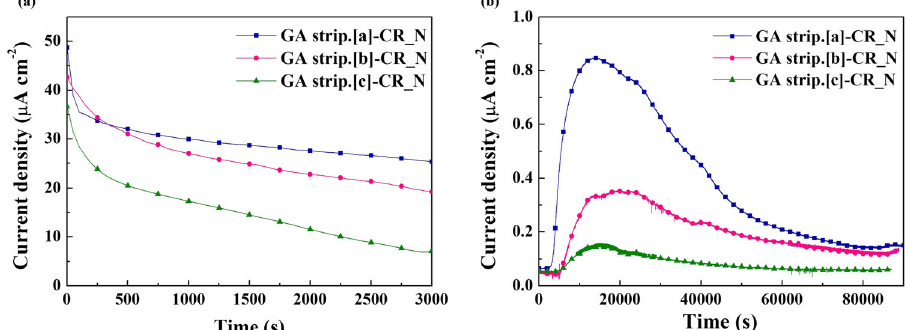
Fig. 13 Galvanic corrosion and hydrogen permeation behaviors using the modi fi ed permeation apparatus. a Galvanic corrosion current densities between the bare steel and stripped GA samples, obtained at respective potential steps (marked as a – c on Fig. 5b) in an electrochemical stripping test in a 3.4 M NaCl + 0.3 M ZnSO 4 solution. b Hydrogen permeation current densities measured in the detection side of bare steel as a result of a